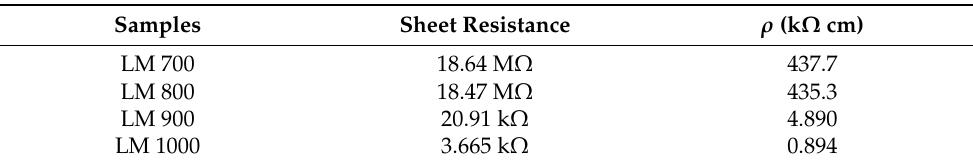
Table 5. Sheet resistances and resistivities of samples calcined at different temperatures. (The pellets thicknesses were 0.518 mm, 0.531 mm, 0.516 mm, and 0.538 mm for LM 700, LM 800, LM 900, and LM 1000, respectively. The spacing between probes was 1.00 mm).